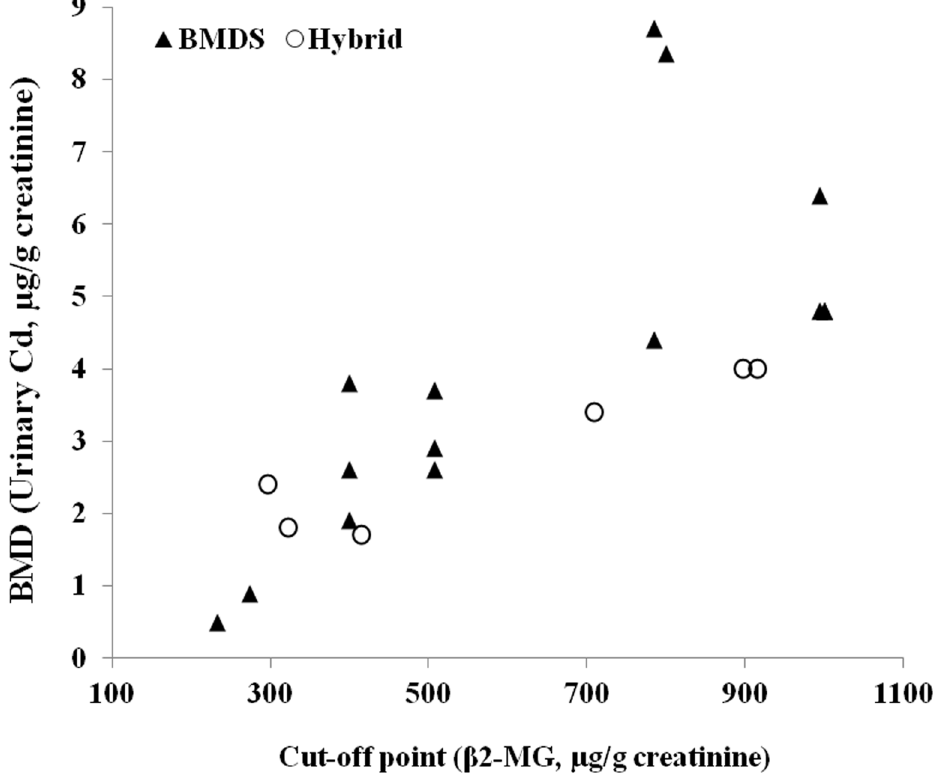
Fig 2. The relationship between cut-off point for adverse effect and urinary BMD for β 2-MG. BMDS ( ▲ ): BMD calculated by EPA BMDS software, Hybrid ( (cid:1) ): BMD calculated by hybrid approach. The positive relationships between cut-off point of β 2-MG and BMD in both conventional quantal analysis and the hybrid approach were